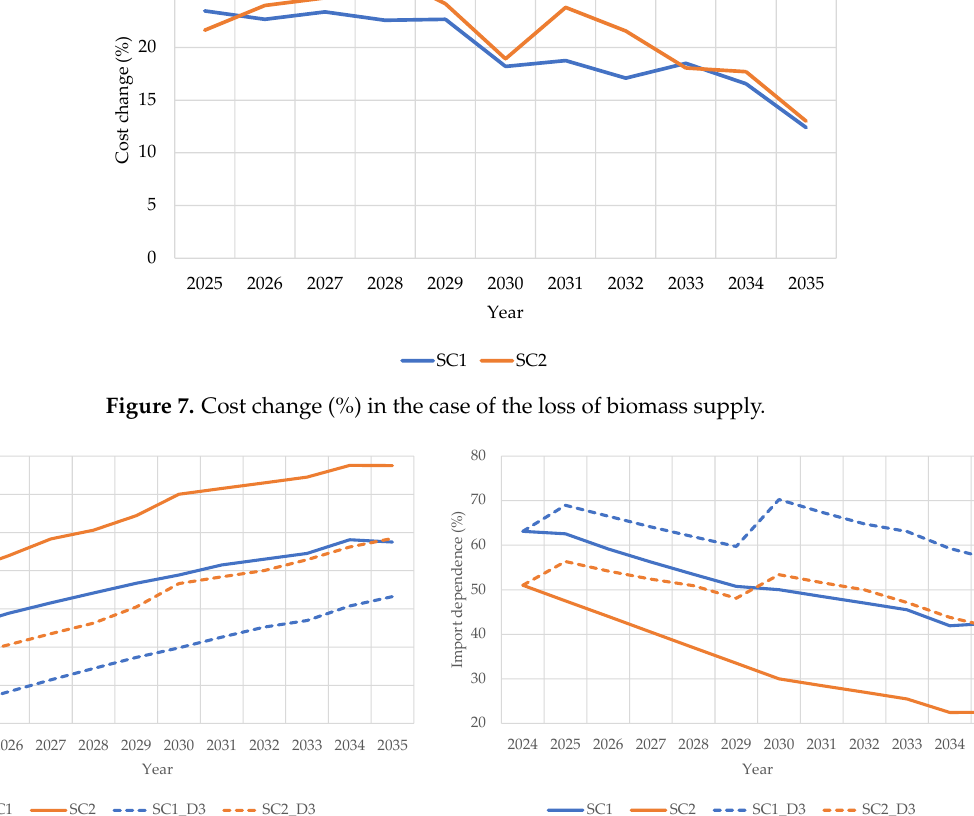
( b ) Figure 9. Diversity indicators in the case of the loss of biomass supply: ( a ) SWI; ( b ) HHI.